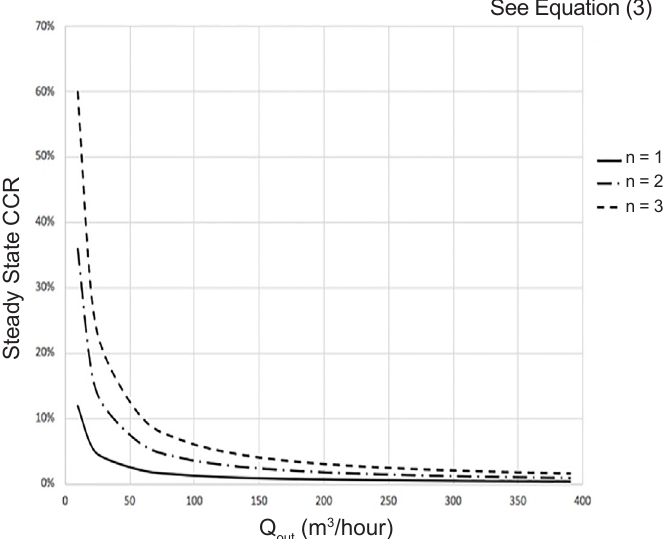
Figure 1. Steady state contaminant concentration ratio for various number of contaminated patients (n) for any reference volume where q breath = 1.2 m 3 /hour. CCR , contaminant concentration